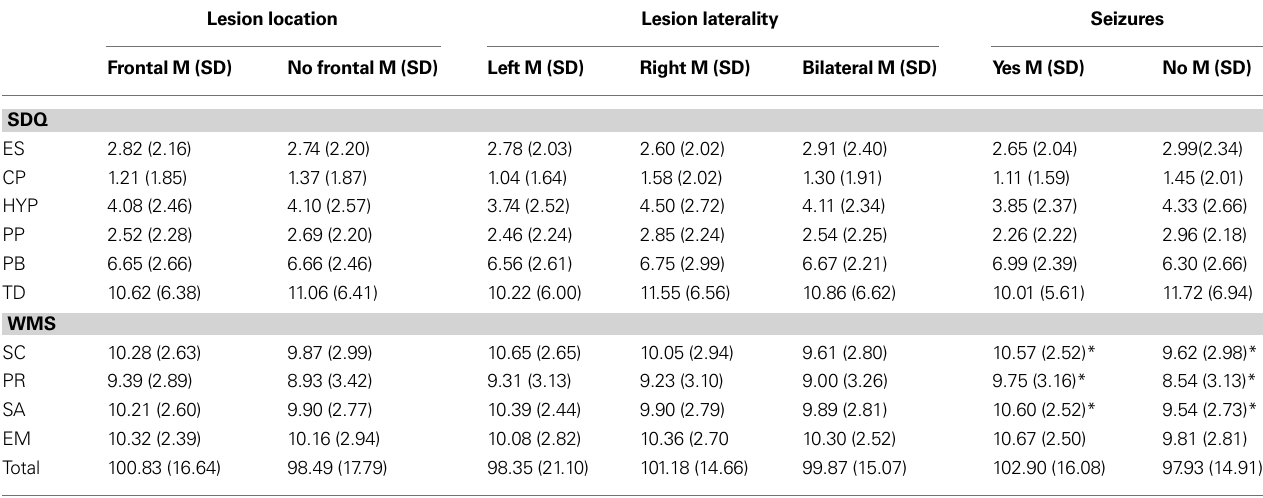
Table 5 | Differences in social functioning ratings for lesion characteristics and seizure history. Lesion location Lesion laterality Seizures